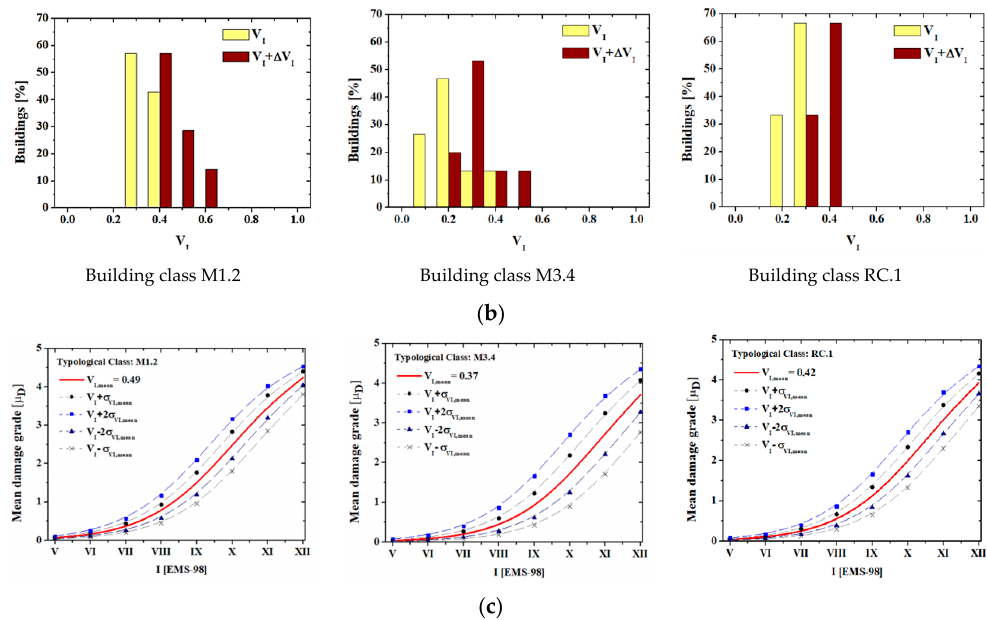
Figure 13. Vulnerability distribution in the inspected area ( a ), corresponding vulnerability frequencies ( b ) and mean vulnerability curves of building classes ( c ).